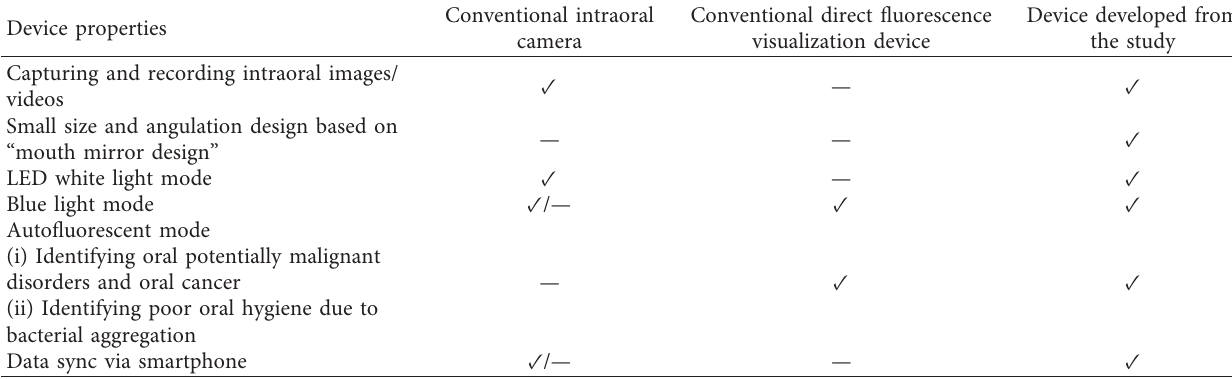
Table 4: The intraoral camera with fluorescent aids for the screening of OPMDs properties.